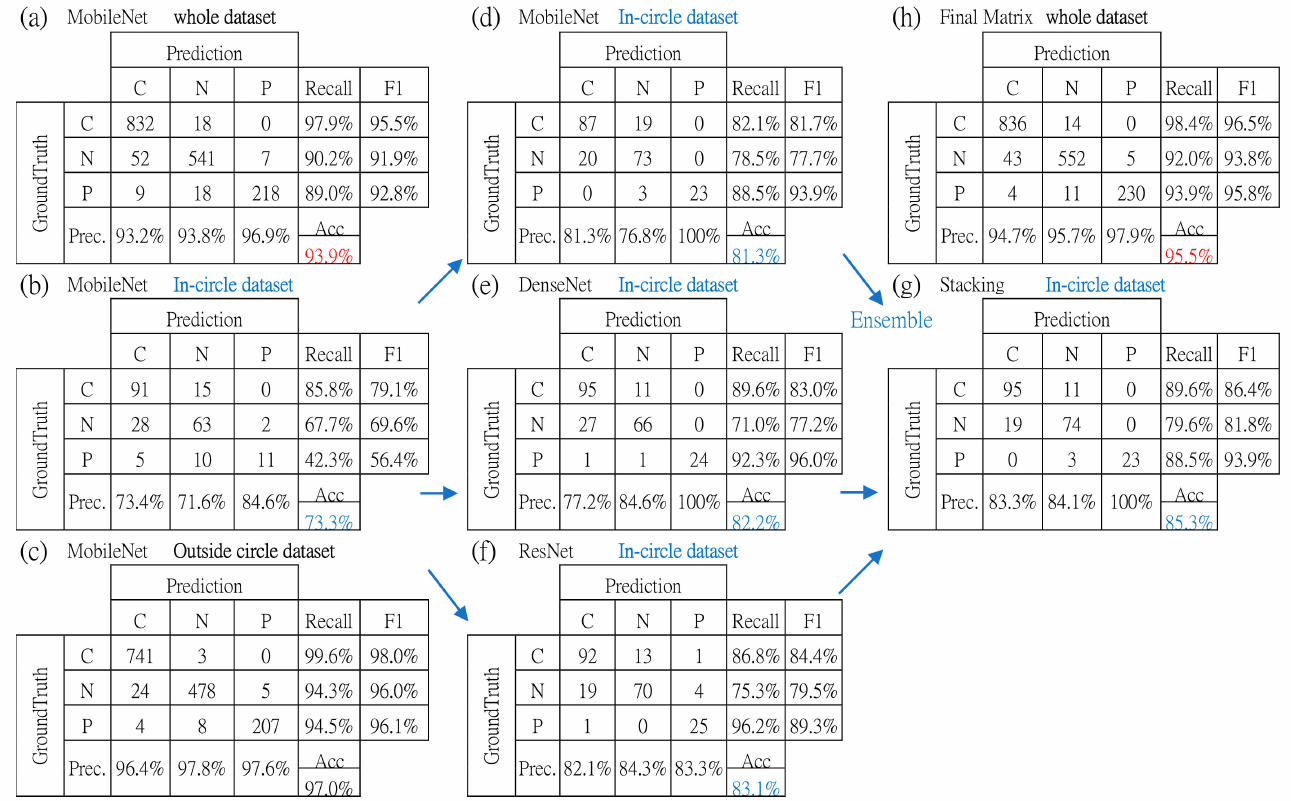
Figure 7. Outlier set and minimum L2 distance to three cluster centers. The number one image, lateral view X-ray, has the shortest similarity distance.